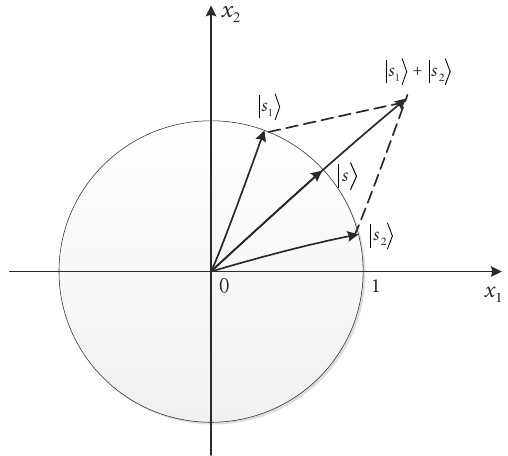
Figure 1. Two dimensional vector space: | s 〉 is the final preference